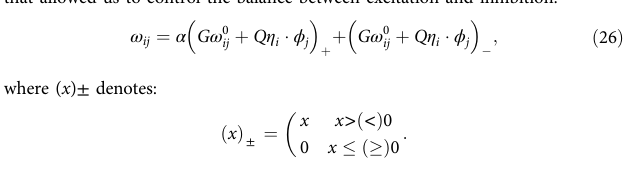
The values α = 1 yield the original weight matrix, while α > 1 ampli fi es the excitatory connections and α < 1 diminishes the excitatory connections. Figure 5 methods . The teaching signal consisted of an 8s movie clip (see [77]). The frames were smoothed and interpolated so that RLS could be applied at any time point, instead of just the fi xed times corresponding to the native frames per second of the original movie clip. The movie was downsampled to 1920 pixels (30 × 64) which formed the supervisor. For both implementations (external and internal HDTS), the replay network consisted of 1000 neurons with G = 5× 10 3 , Q = 4× 10 2 , λ − 1 = 2ms, Δ t = 4 ms and an integration time step of 0.04ms. For the external HDTS network, an HDTS was generated with 32 pulses that were 250 ms in duration. The HDTS was multiplied by a static, N × 32 feedforward weight matrix, W in where each weight was drawn uniformly from [ − 4× 10 3 , 4 ×10 3 ] and 74 s of FORCE training was used. The network was simulated for another 370 s after RLS was turned off to test if learning was successful. For the internal HDTS case, a separate HDTS network was trained with 2000 neurons. The supervisor for this network consisted of a 64-dimensional HDTS with pulses that were 125 ms in duration. The HDTS was fed into an identical replay network as in the external HDTS case. The replay network was trained simultaneously to the HDTS network and had G = 1× 10 4 , Q = 4 ×10 3 . The HDTS was fed into the replay network in an identical manner to the external HDTS case. RLS was applied to train the HDTS and replay network with identical parameters as in the external HDTS case, only with a longer training time (290 s). We note that for this movie example, the network could also learn the output with only the static, chaos inducing weight matrix and the feedforward HDTS inputs ( Q = 0). However when Q = 0, the network behavior is similar to the more classic liquid state regime. Data availability . The code used for this paper can be found on modelDB 31 , under accession number